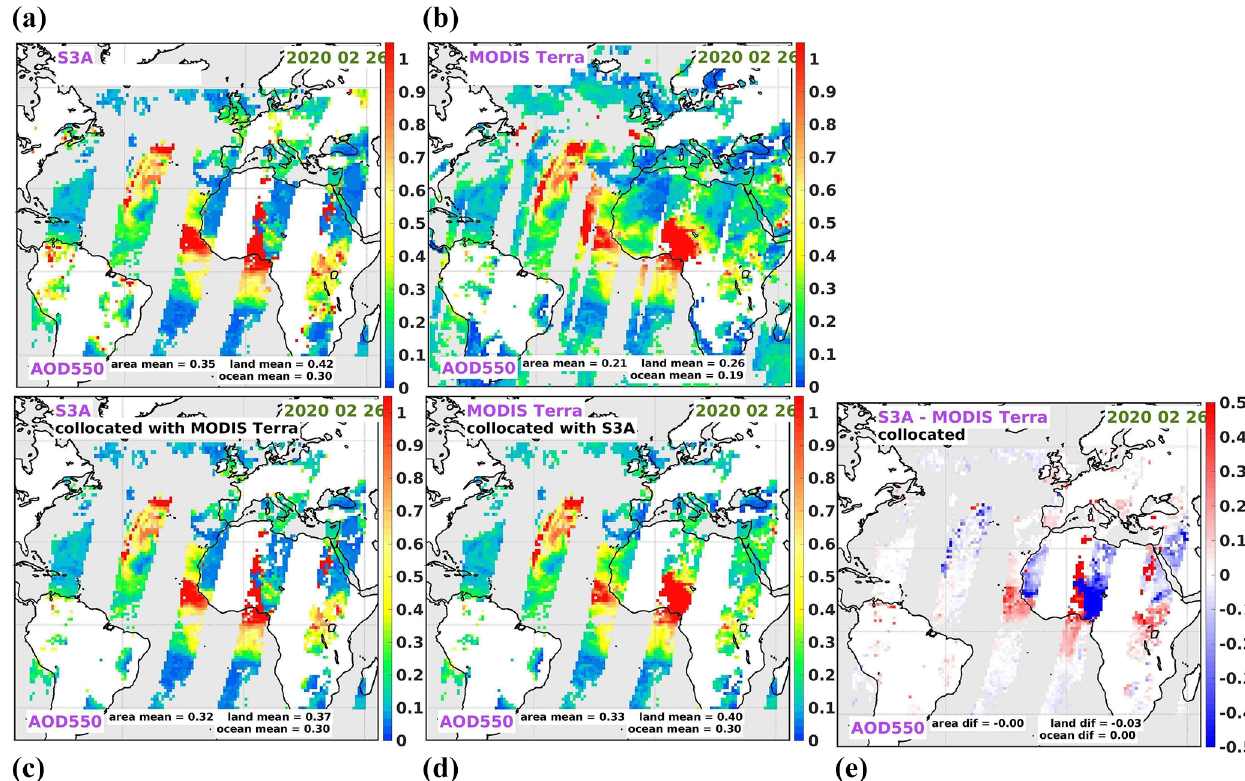
Figure 27. For 26 February 2020, all pixels available in S3A syAOD 550 (a) and MODIS modAOD 550 (b) products. Pixels existing in both products (collocated products), syAOD 550 (c) and modAOD 550 (d) , as well as the difference between syAOD 550 and modAOD 550 (e) . For each sub-plot, statistics (mean AOD for the whole area and separately for land and ocean) are